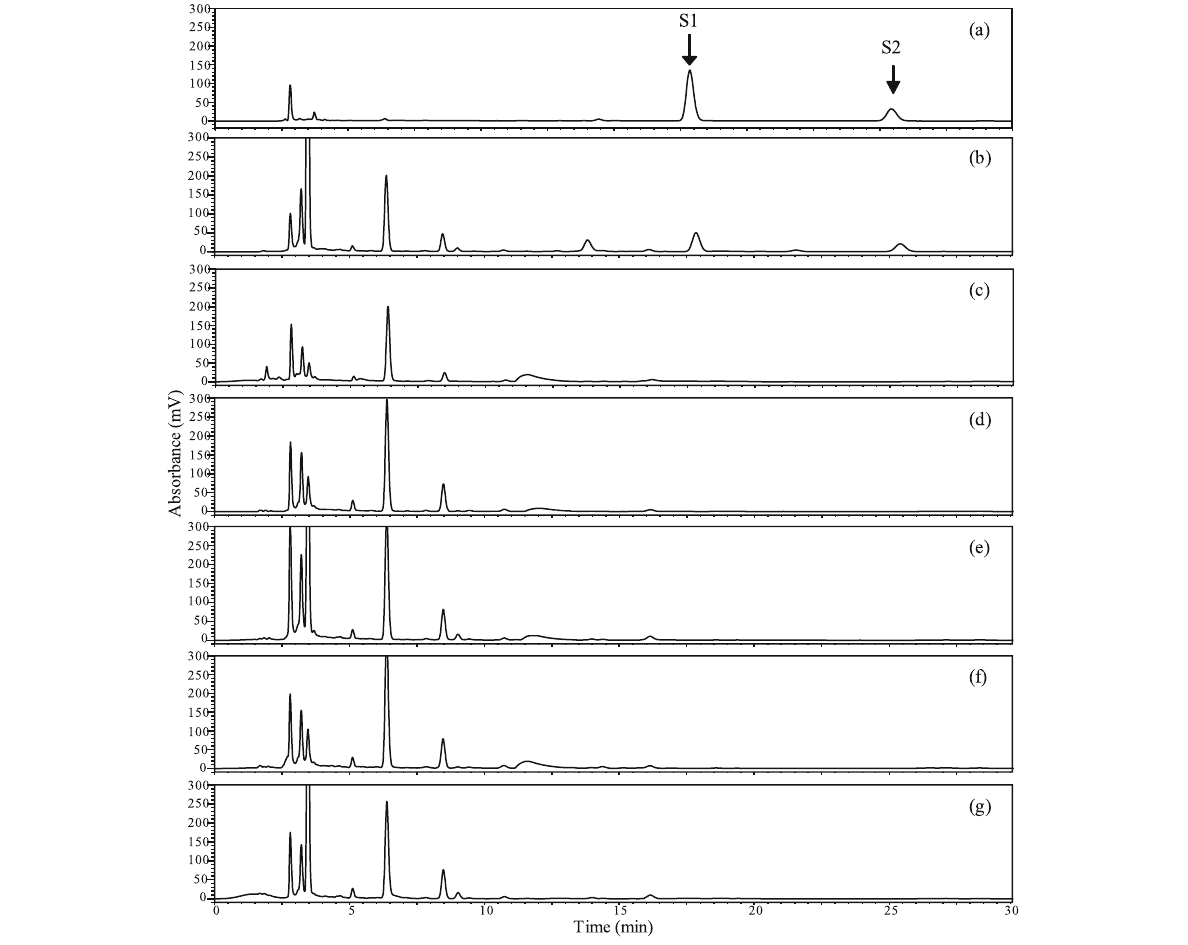
Fig. 3 Chromatographic pattern analysis of ( a ) a mixture of standards, ( b ) Inonotus obliquus , ( c ) Inonotus hispidus , ( d ) Auricularia auricula-judae , ( e ) Ganoderma lucidum , ( f ) Lentinula edodes , ( g ) Phellinus linteus . S1: inotodiol; S2: 3 β -hydroxylanosta-8,24-dien-21-al. HPLC conditions: column,